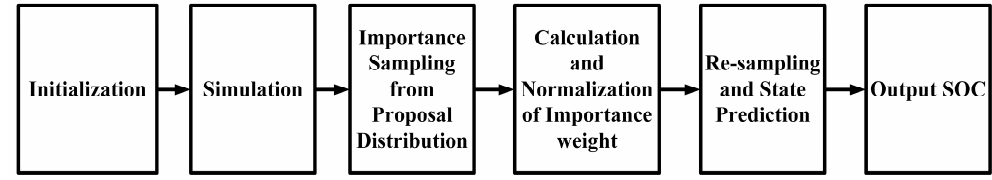
Figure 70. Working principle of the SOC measuring algorithm proposed by Zhou et al. [180].